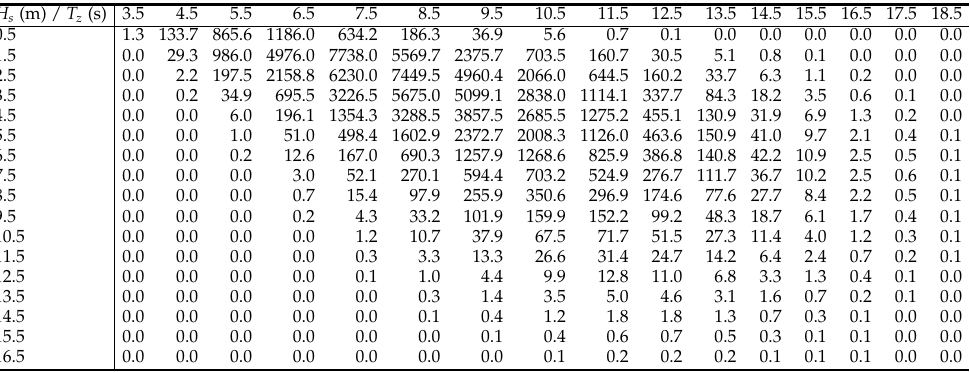
Table 1. Wave scatter data for IMO Second Generation Intact Stability guidelines, adopted from IACS Standard Wave Data [25]. Number of occurrences: